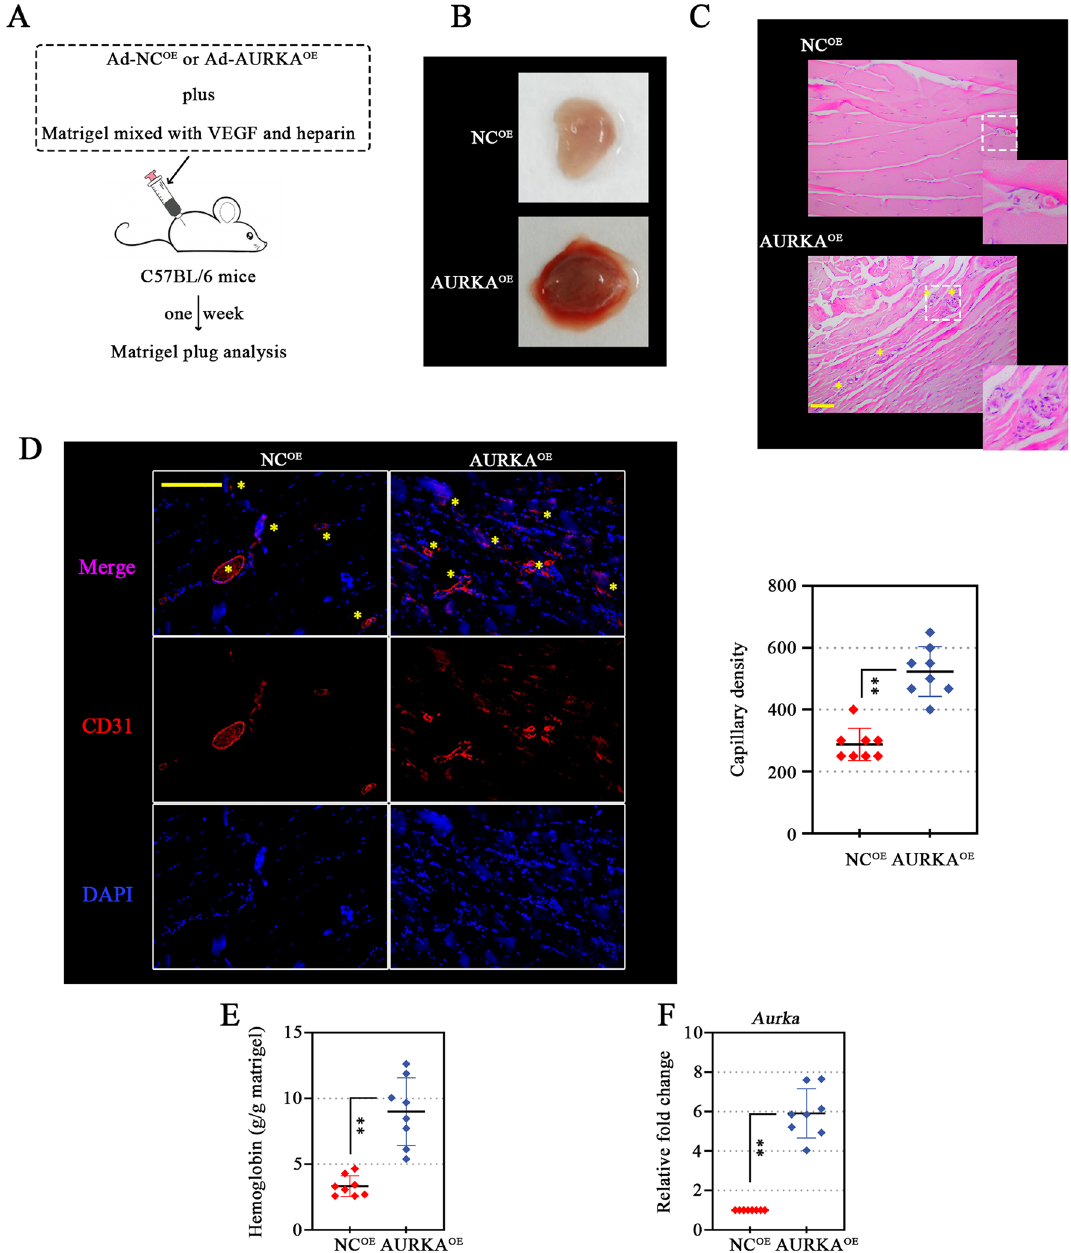
Fig. 5 AURKA overexpression enhances neovascularization in vivo. In vivo matrigel plug implant model using C57BL/6 mice was performed by subcutaneous injection of Matrigel mixed with AURKA overexpressing-adenovirus (AURKA OE ) or its negative control (NC OE ) ( A ). One week after, a gross matrigel plug image was taken ( B ). Slides of each matrigel plug were stained with hematoxylin and eosin (H&E) to observe angiogenesis response (asterisk marks) in vivo ( C ) (scale bar, 100 μm). Slides of each matrigel plug were subjected to CD31 immunofluorescence staining to visualize (left) and quantify (right) capillary density ( D ). Pink spots (asterisk marks) were scored as positive-stained CD31 (scale bar, 200 μm) ( D ). The hemoglobin concentration of matrigel plug was investigated, reflecting new blood vessels formation ( E ). The mRNA expression of AURKA was further validated in matrigel plug ( F ). Data were represented as mean SD. ** P < 0.01. Each dot indicated a biological replicate, n ± =